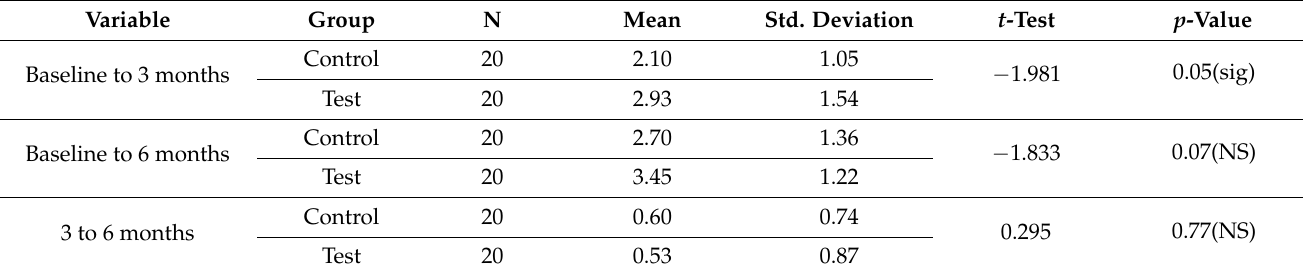
Table 5. Independent t -test for the difference in mean CAL gain.